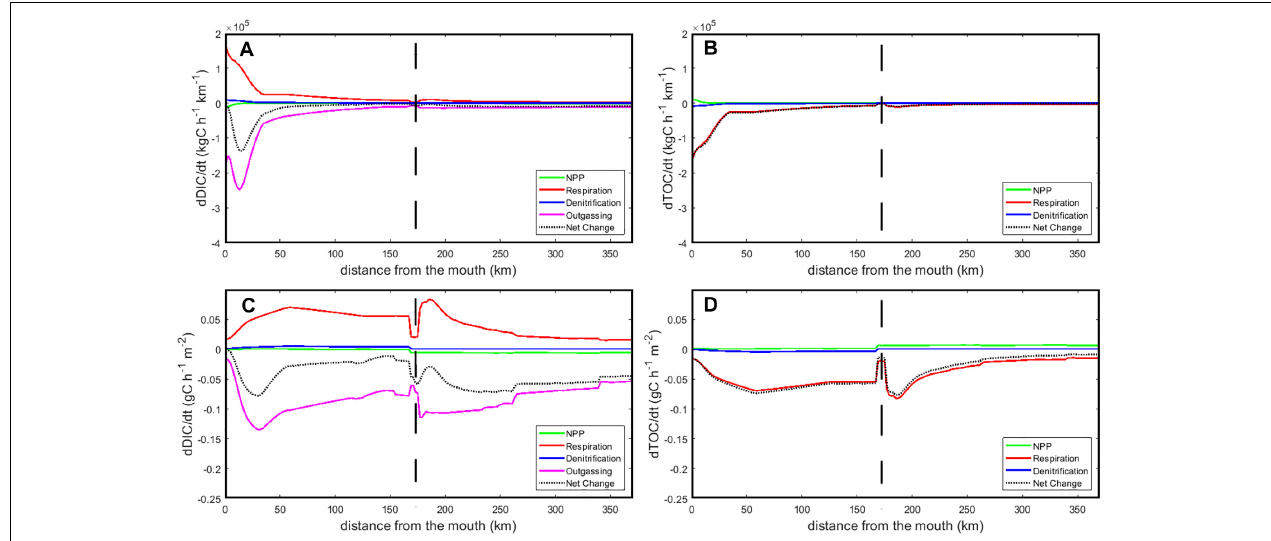
FIGURE 7 | Longitudinal profiles along the main axis of the Seine of the different processes affecting the DIC (A,C) and TOC pools (B,D) . In the top panels (A,B) , the process rates are integrated over the Seine’s width while they are reported per surface area in the bottom panels (C,D) . Zero is the mouth of the estuary in Le Havre, vertical dashed lines, represent Poses, Paris corresponds to kilometer 370.